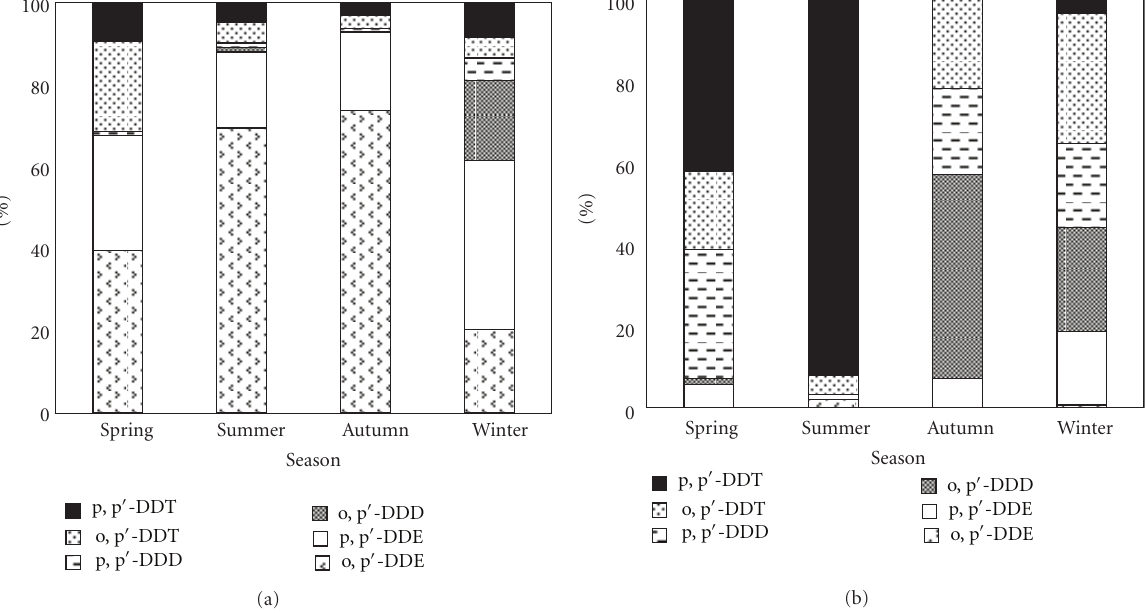
Figure 4: Seasonal variations of DDTs in the gas phase (a) and particle phase (b) at Lake Chaohu from March 2010 to February 2011.